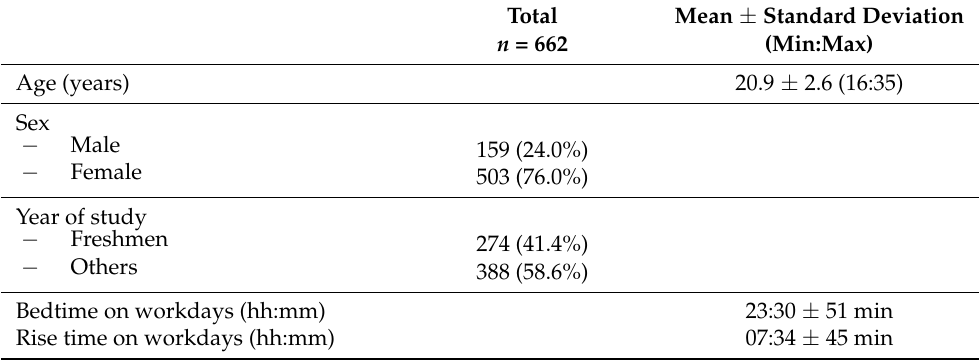
Table 2. Descriptive characteristics ( n =